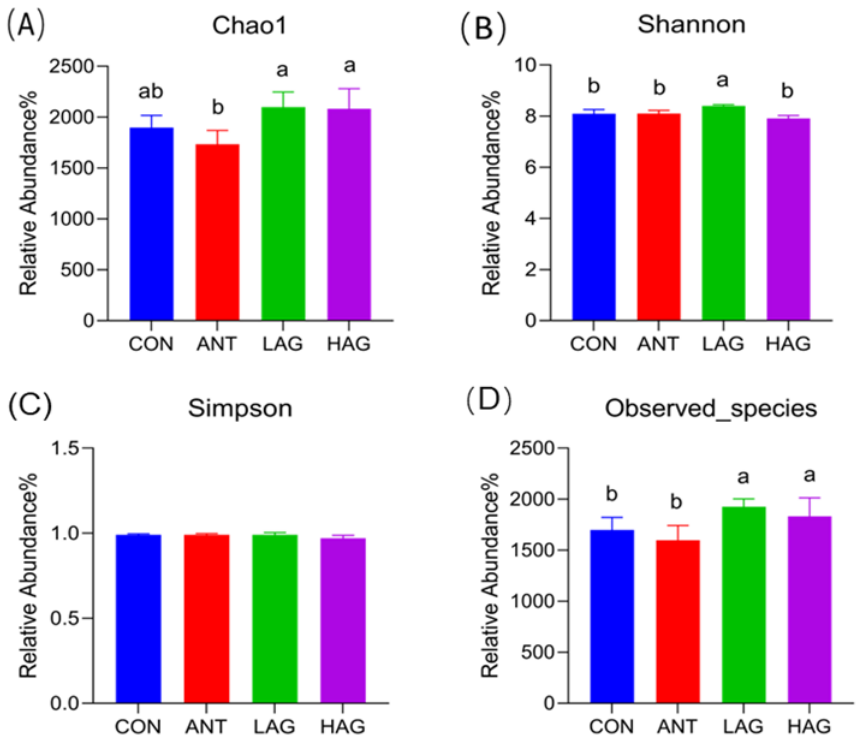
Figure 2. ( A – D ) . Effects of Astragalus-Glycyrrhiza polysaccharides on alpha diversity index of cecal microbiota in broilers. Means with different small letters indicate significant differences ( p < 0.05).